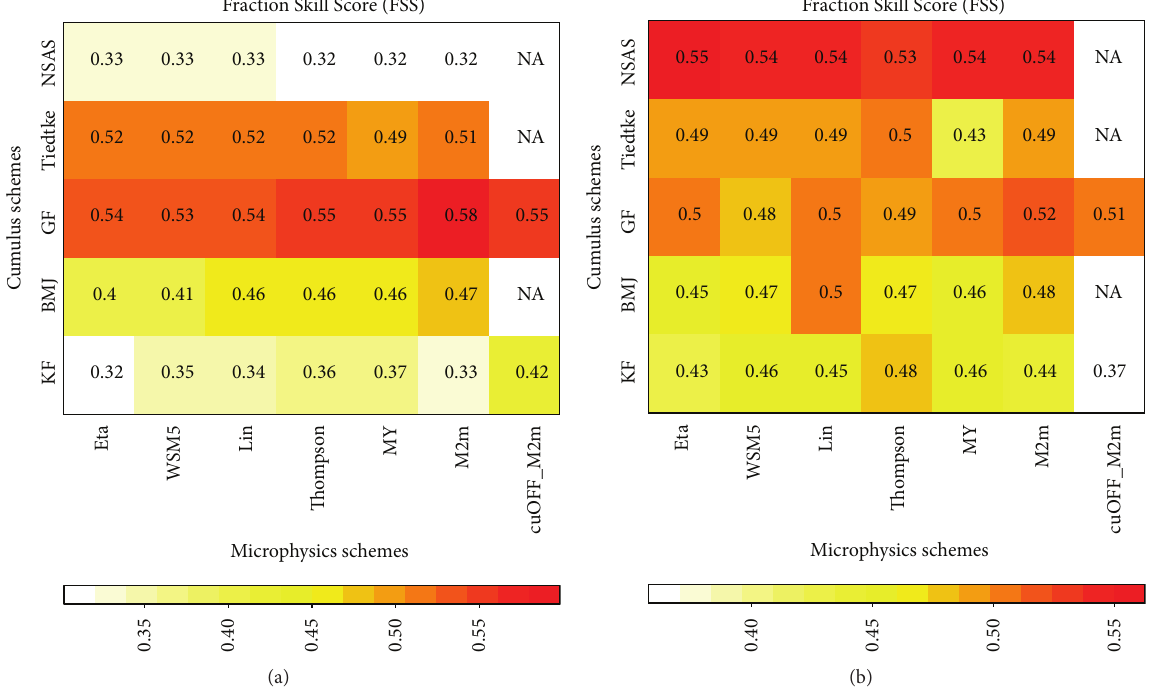
Figure 10: FSS for all experiments using (a) thresholds of 0.1mm and (b) 0.5 mm and a scale of one grid square. Valid for 2000 UTC, 1 May 2012.